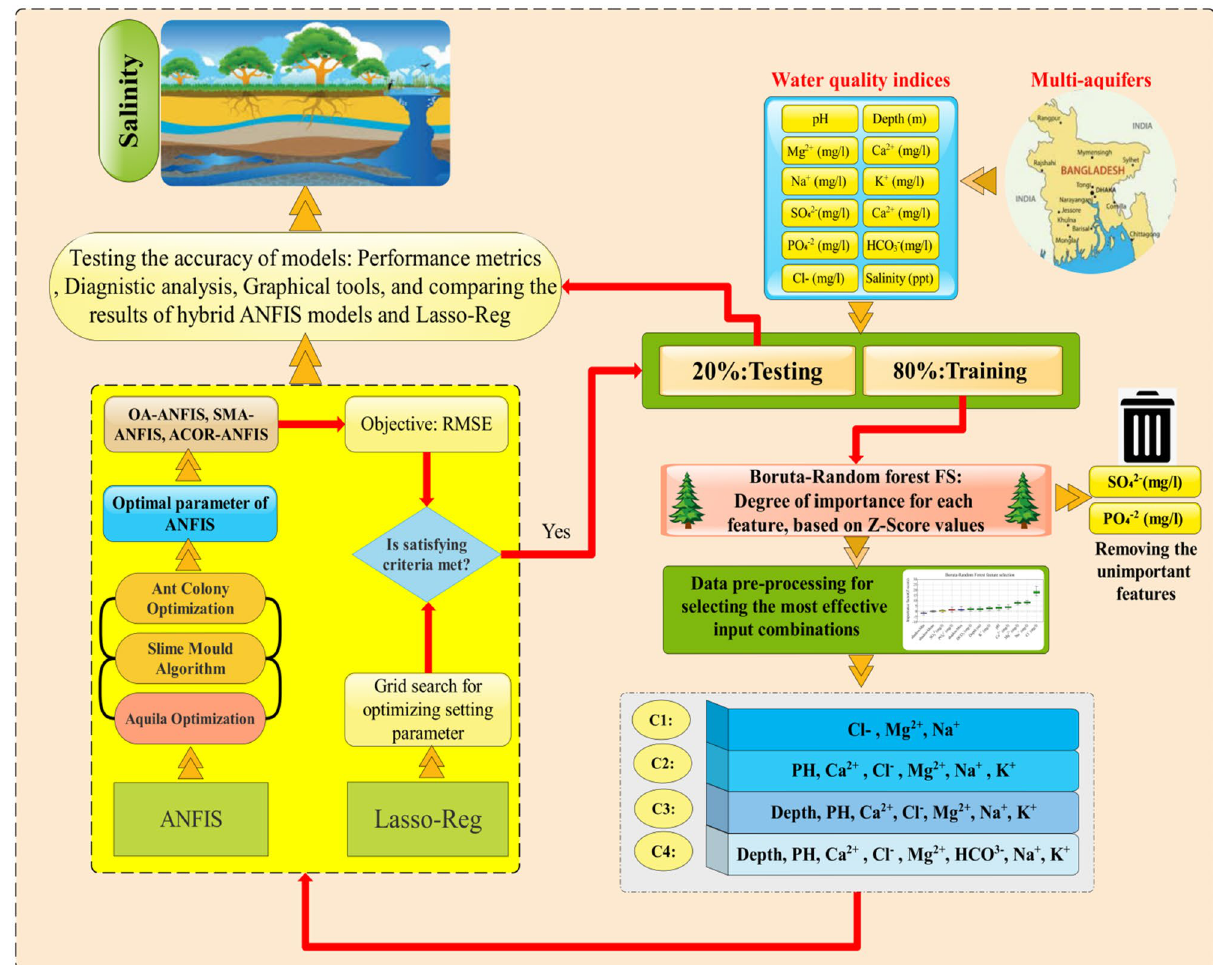
Figure 6. Workflow of salinity modeling based on a new ML-based hybrid strategy for multi-aquifers in coastal regions of